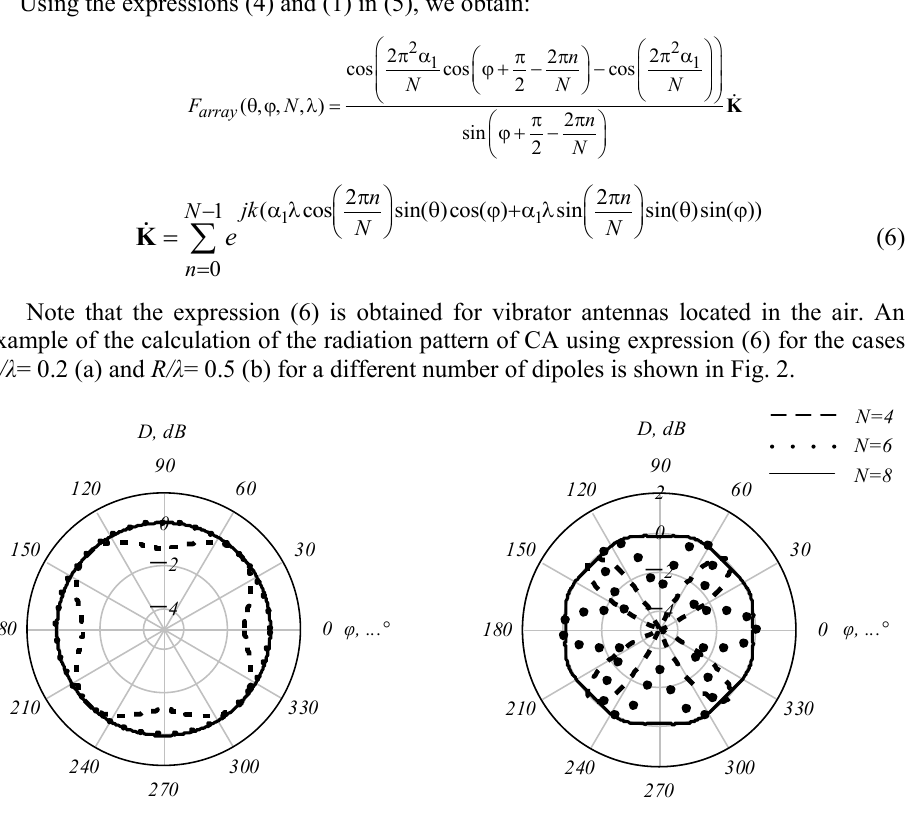
 Fig. 2. Radiation pattern of the CA at various N and R/λ